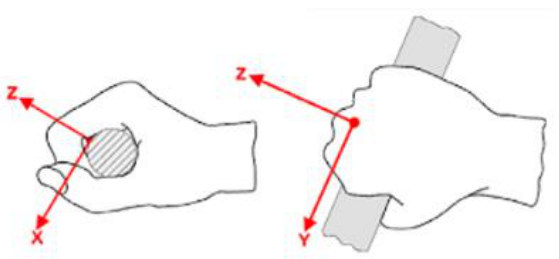
Figure 3. Axes direction defined in relation to the body hand (hand reference system).